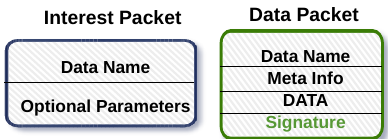
Figure 2. NDN interest (consumer) and data (producer) packets form (Adapted from